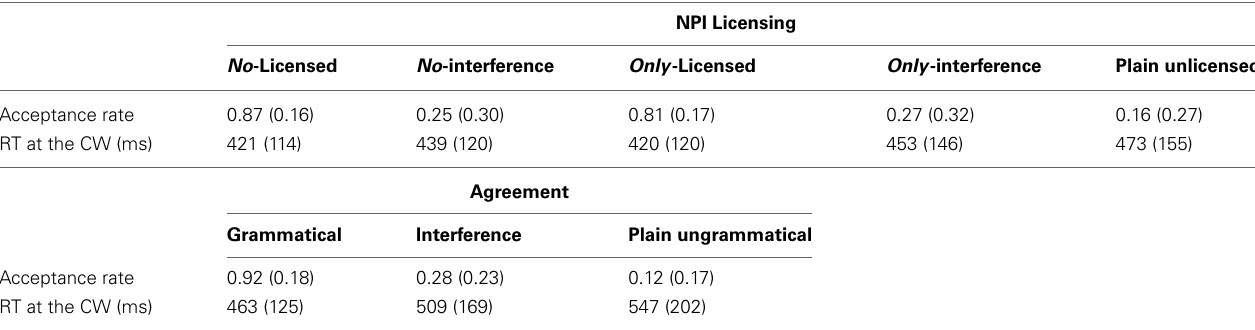
Table 2 | Average acceptance rate and RTs on the critical word, presented separately for the NPI and the agreement items (with sd in the parenthesis).